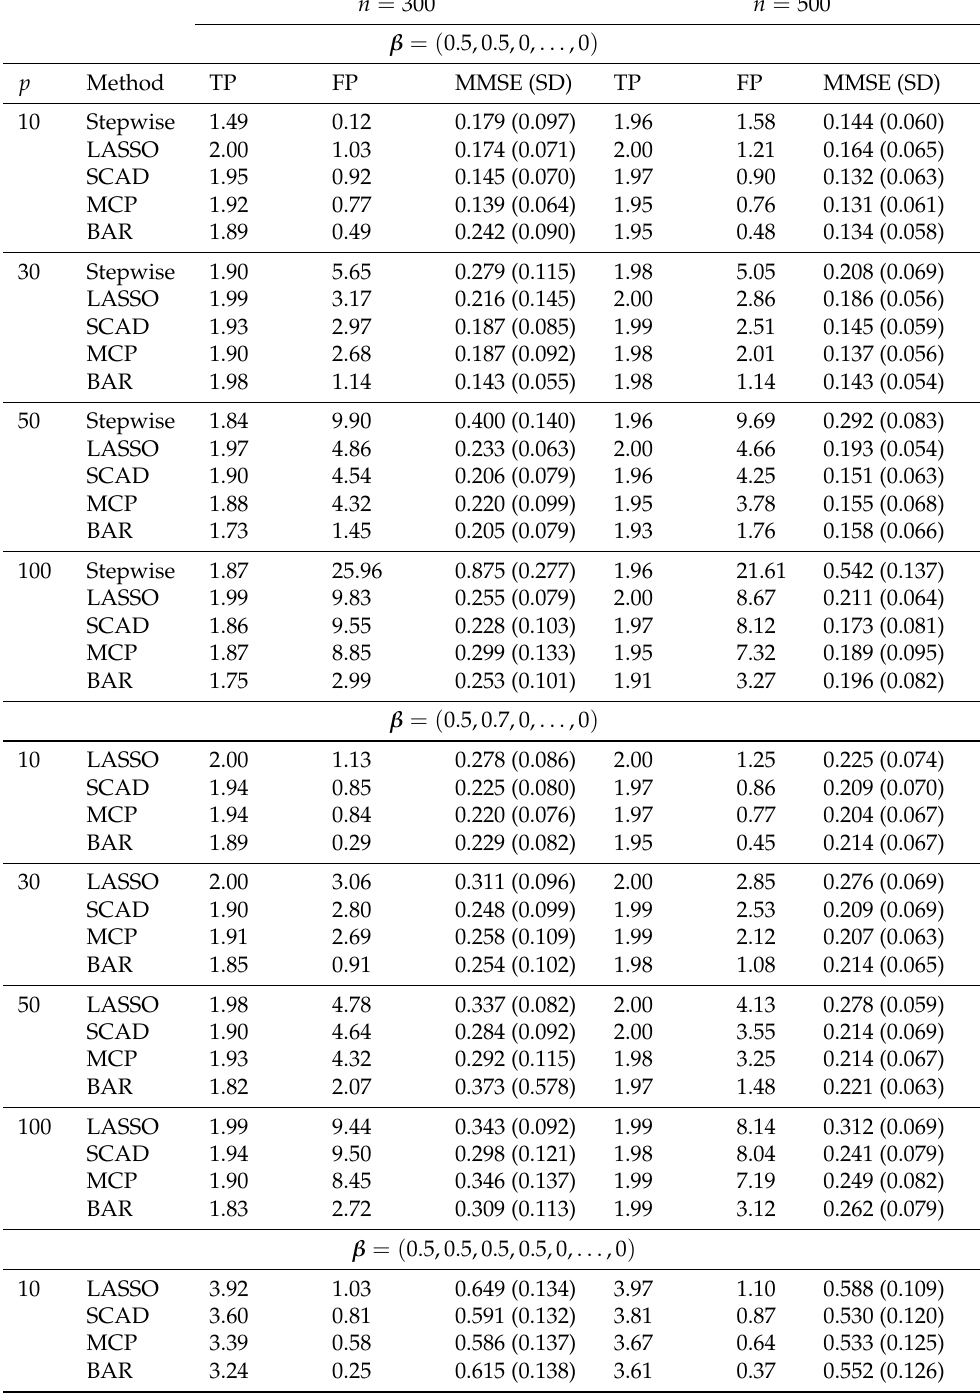
Table 1. Simulation results based on the joint selection of the tuning parameter and bandwidth for (I). n = 300 n = 500 β = ( 0.5,0.5,0, . . . ,0